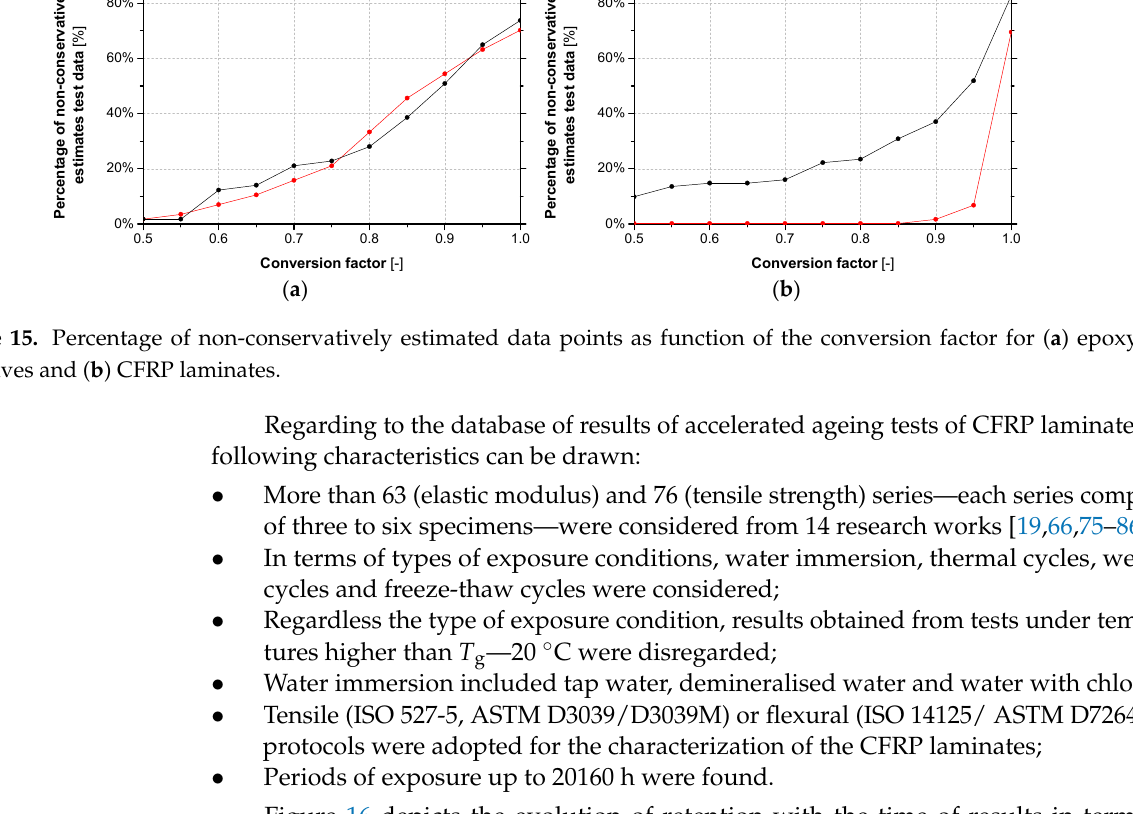
( b ) Figure 16. Retention values of ( a ) elastic modulus and ( b ) tensile strength of CFRP laminates un- der accelerated ageing tests protocols versus natural ageing (E3 to E6). Again, despite the dispersion of results, from these graphs it becomes clear that for similar periods of exposure, in general accelerated ageing tests yield similar or lower val- ues of the retention parameter, when compared with natural ageing. When retention val- ues lower than 1.0 are considered, average retentions of the tensile strength equal to 0.74